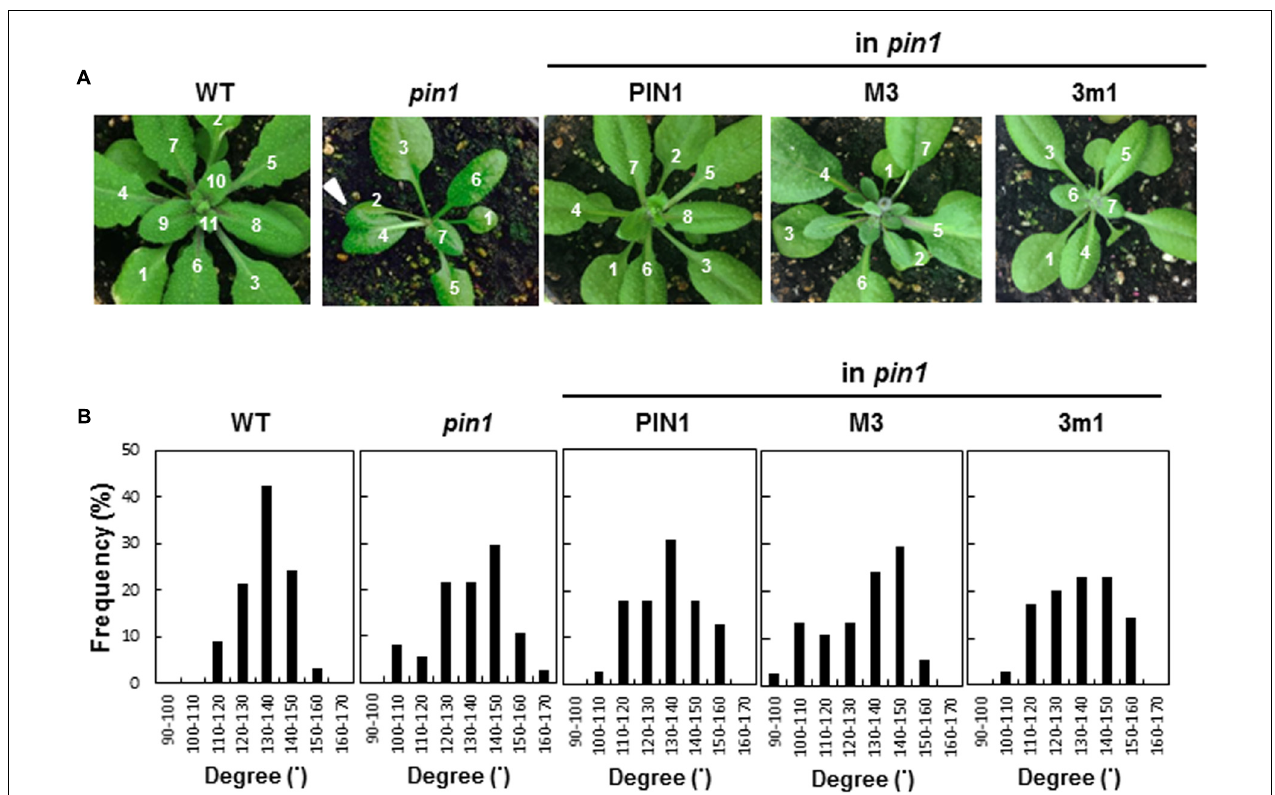
FIGURE 3 | Effect of M3 or 3m1 mutation of PIN1 on phyllotaxis of vegetative leaves. (A) Rosette leaves of wild-type (WT), homozygous pin1 , and homozygous pin1 complemented with PIN1 ( ProPIN1:PIN1:GFP ), M3PIN1 (M3, ProPIN1:M3PIN1:GFP ), and 3m1PIN1 (3m1, ProPIN1:3m1PIN1:GFP ). Arrow head indicates fused leaf shown in pin1 mutant. (B) Distribution of leaf-emerging angles in the plants described in (A) ( n = 33–39 plants; in case of transgenics, from 5 to 7 independent lines for each